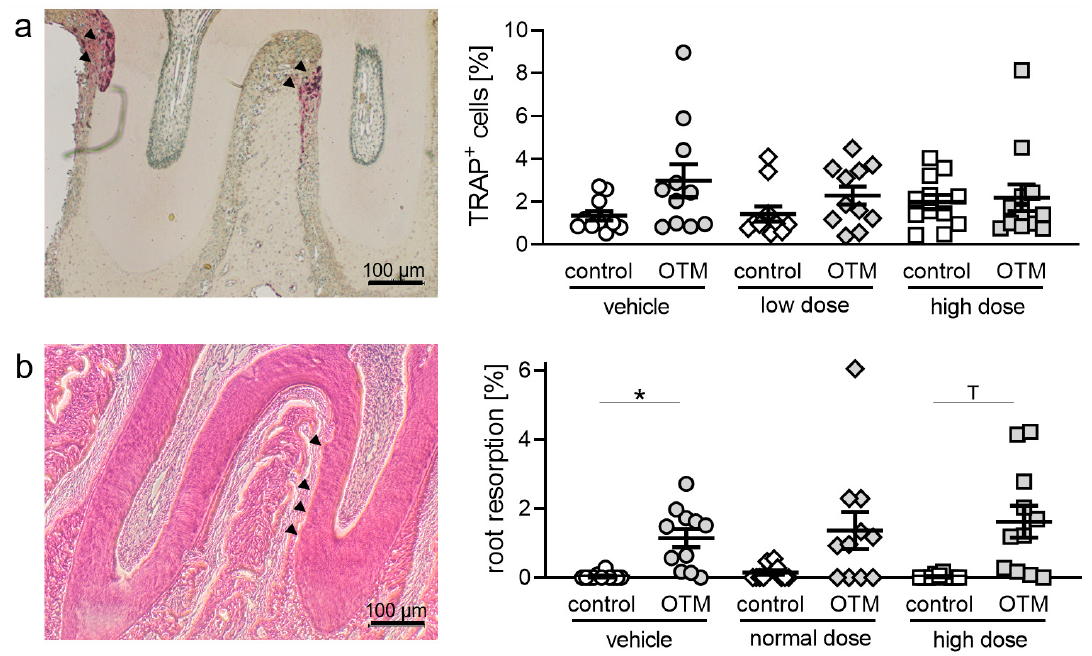
Figure 2. ( a ) Tartrate-resistant acid phosphatase (TRAP) + (osteoclast-like) cells and ( b ) root resorption at the distobuccal root of the upper first molar at the control and orthodontically treated (OTM) jaw side after 28 days. n = 11. Statistics: Welch-corrected ANOVA followed by Games-Howell multiple comparison tests. T p < 0.1; * p < 0.05.